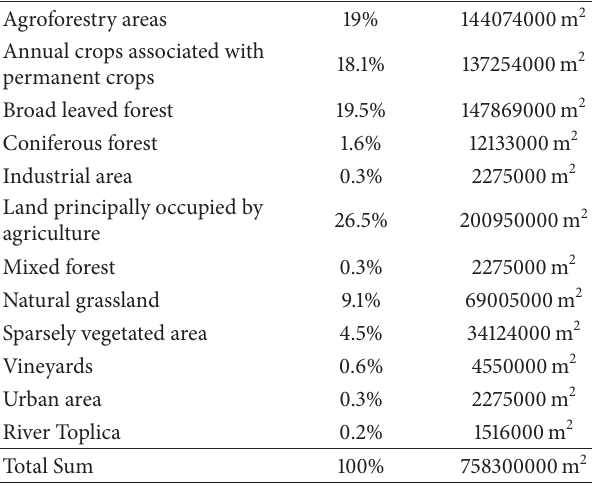
Table 2: The percentage and area of types of land on the territory of Prokuplje Municipality in m 2 in